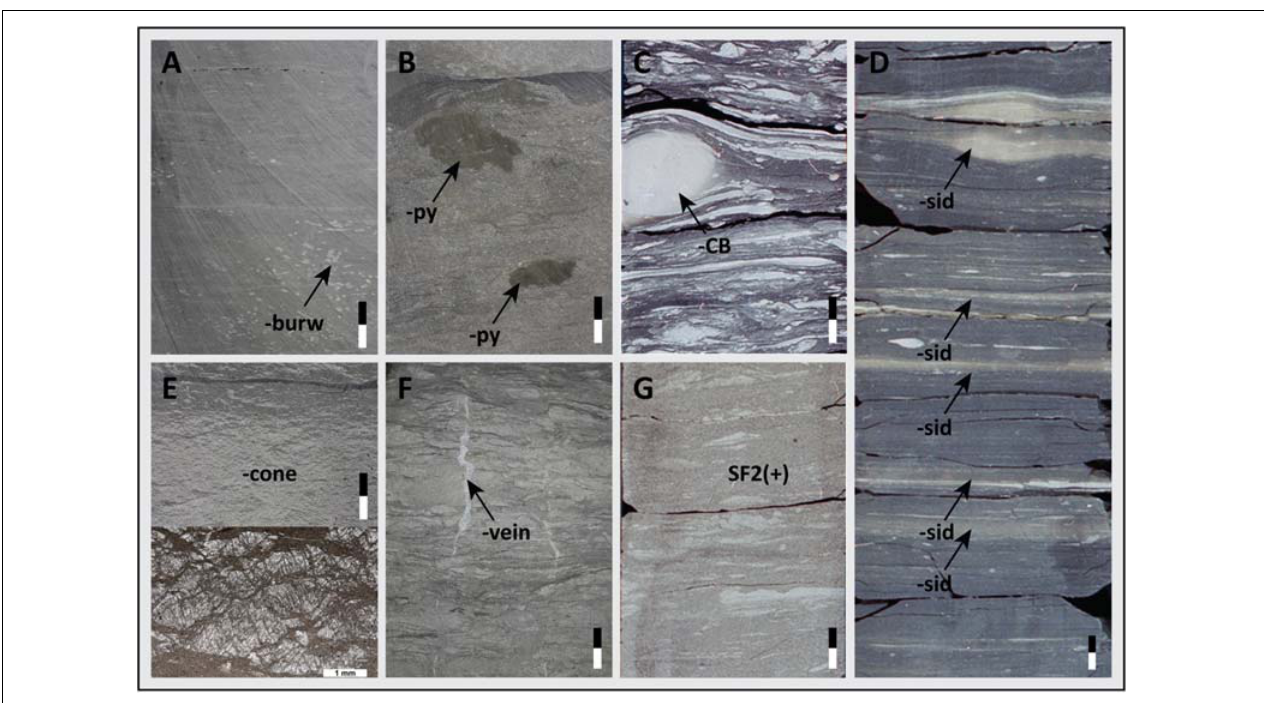
FIGURE 4 | Examples of additional attributes subfacies characteristics (and corresponding abbreviations for the extension of the classification scheme). (A) Accumulation of mm-sized bioturbational features (arrow) within SF1 (Mont Terri). Highlighted by the abbreviation “-burw.” (B) Presence of cm-thick pyritic concretions (arrows) within SF4 (Mont Terri). Highlighted by the abbreviation “-py.” (C) Arrow points to a cm-thick carbonate nodule (Riniken). Highlighted by the abbreviation “-CB.” CB refers to concretionary bodies and includes indifferently concretions and nodules (sensu Sellés-Martínez, 1996). (D) Diagenetic sideritic layers (arrows) within the lower OPA (borehole Riniken; SF1). Highlighted by the abbreviation “-sid.” (E) Eight-cm-thick, calcitic layers with cone-in-cone structures (Mont Terri). Highlighted by the abbreviation “-cone.” The lower part shows the cone-in-cones microfacies (plane-polarized light, × 25 magnification). (F) Thin calcitic vein (arrow) within SF3 (Mont Terri). Highlighted by the abbreviation “-vein.” (G) Atypical SF2 (Weiach): poorer distinction between “lenses” and “matrix” than classical SF2 (coarser/lighter “matrix,” more silt content). The suffix (+) can be used to highlight the atypical aspect and above-average quartz/carbonate content (mainly within the “matrix”) with respect to the selected subfacies type. Scale bar = 2